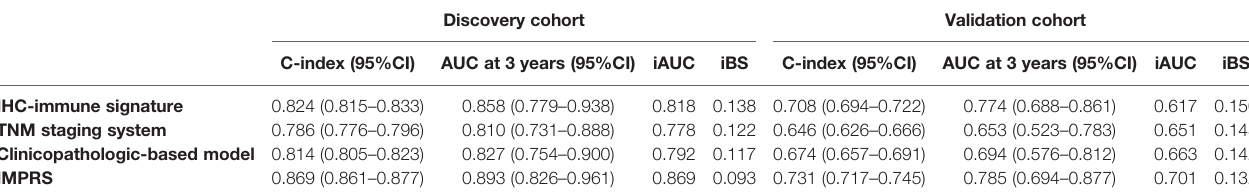
TABLE 4 | Prediction performance of IHC-immune signature, IMPRS, and clinicopathological-based model in all patient cohort.